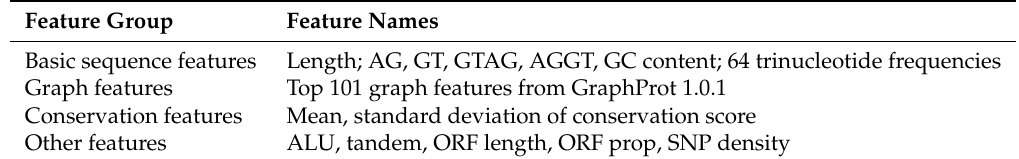
Table 2. The 178 extracted features divided into four